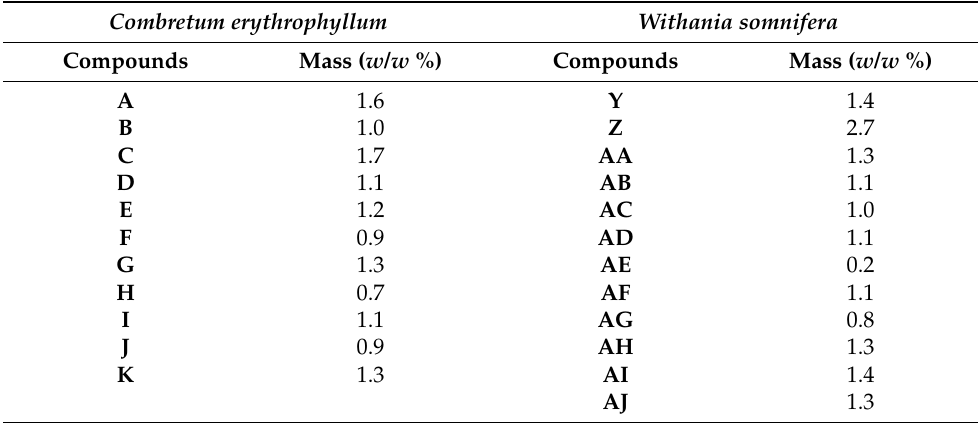
Table 3. Masses of the compounds ( w / w ) isolated from leaf extracts of Combretum erythrophyllum and Withania somnifera